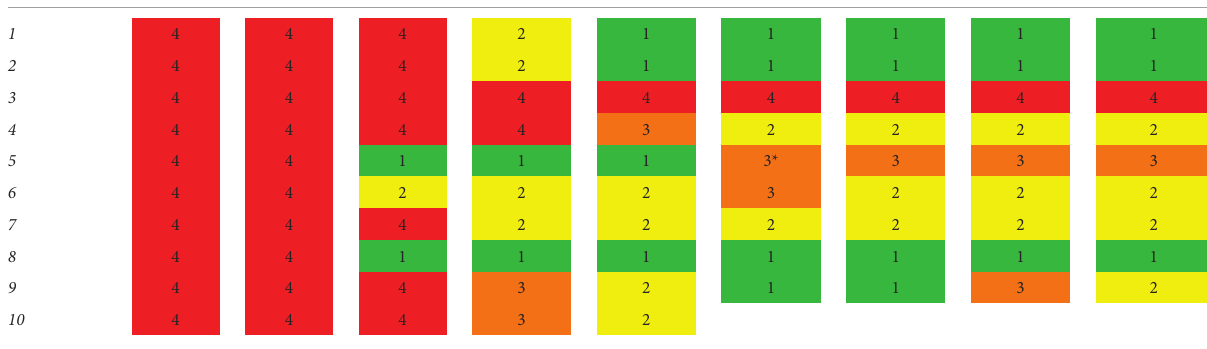
TABLE 2 Engel class